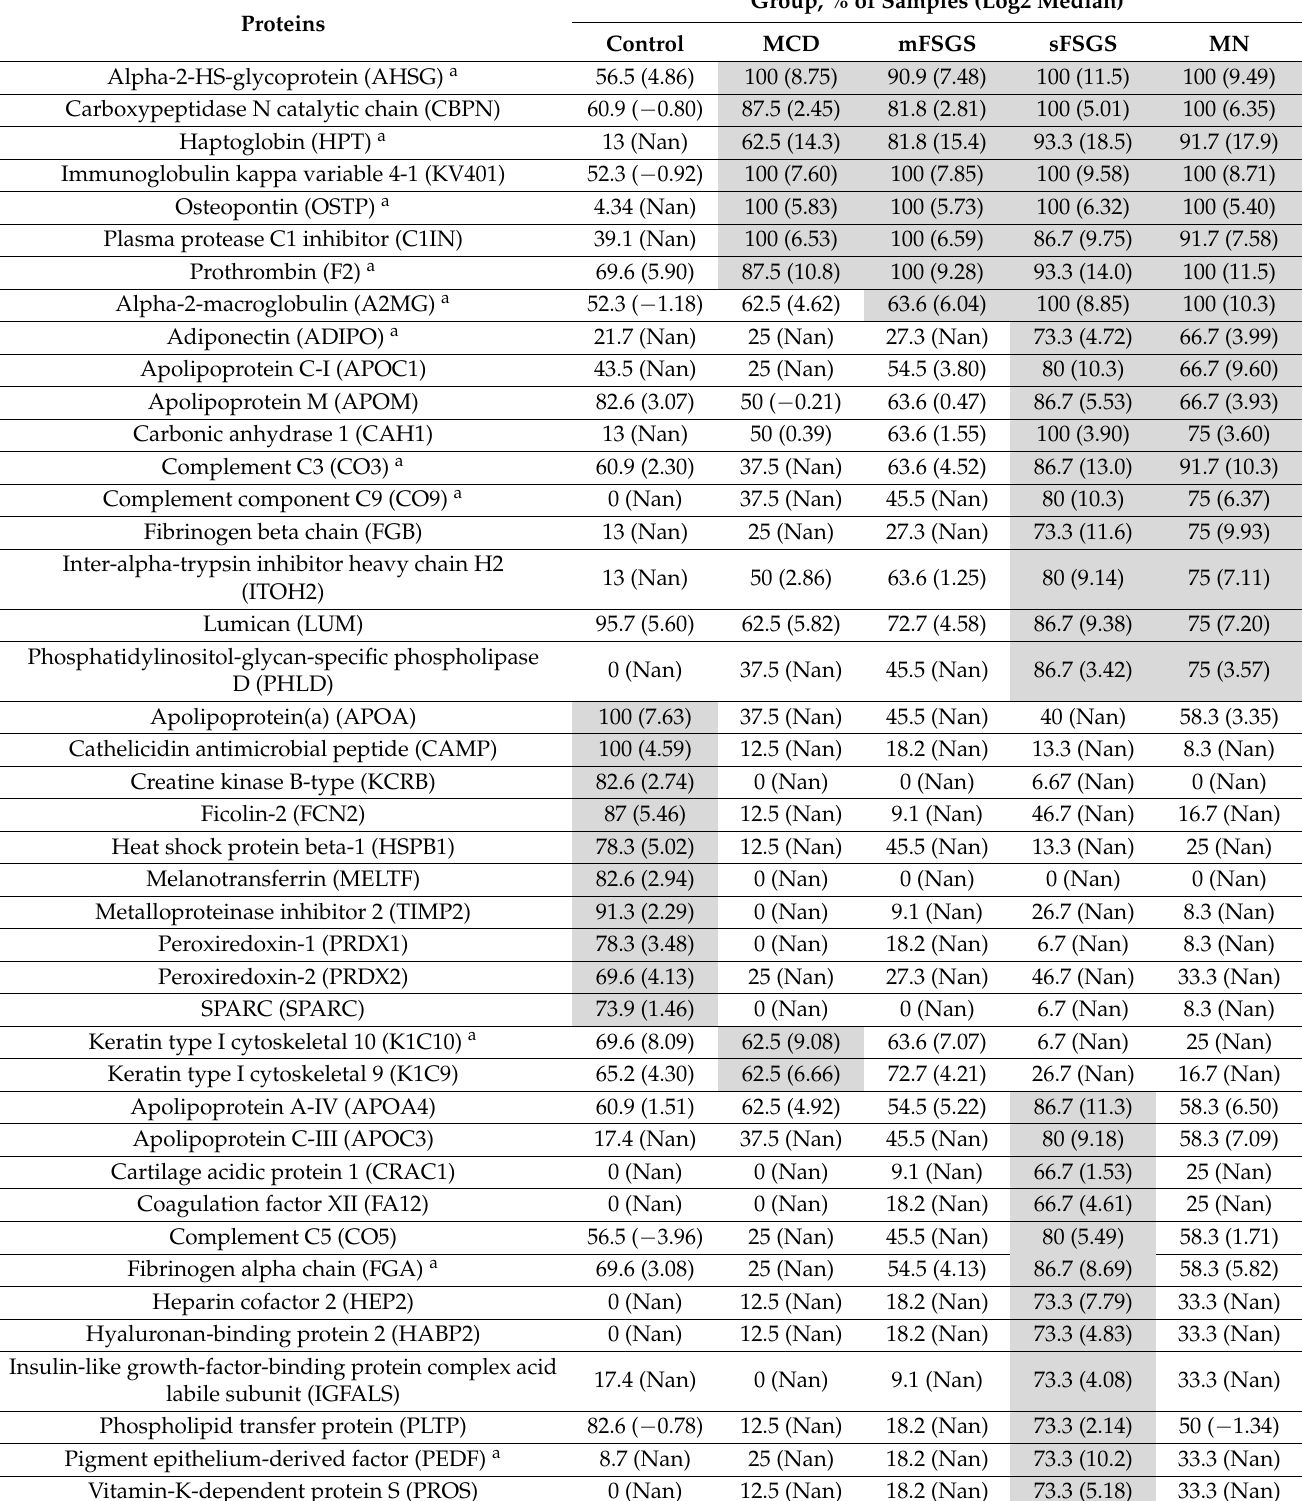
Table 2. Potential protein markers prevalent only in certain